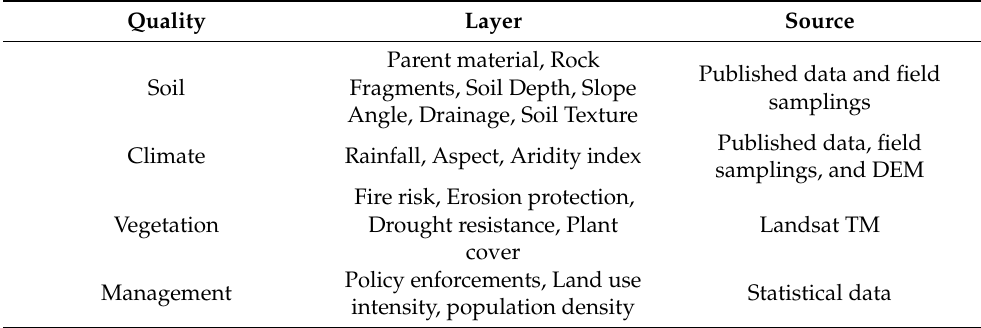
Table 1. Input variables for ESA frameworks assessing land degradation and the related